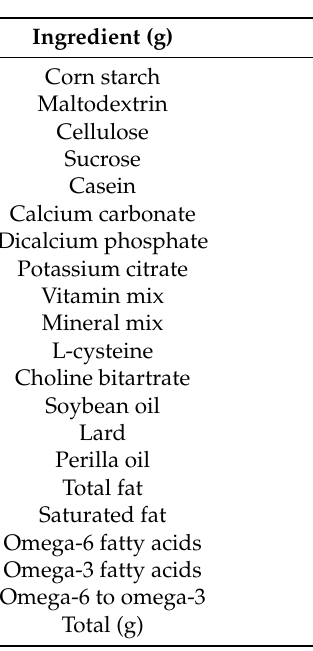
Table 2. Ingredients of the experimental